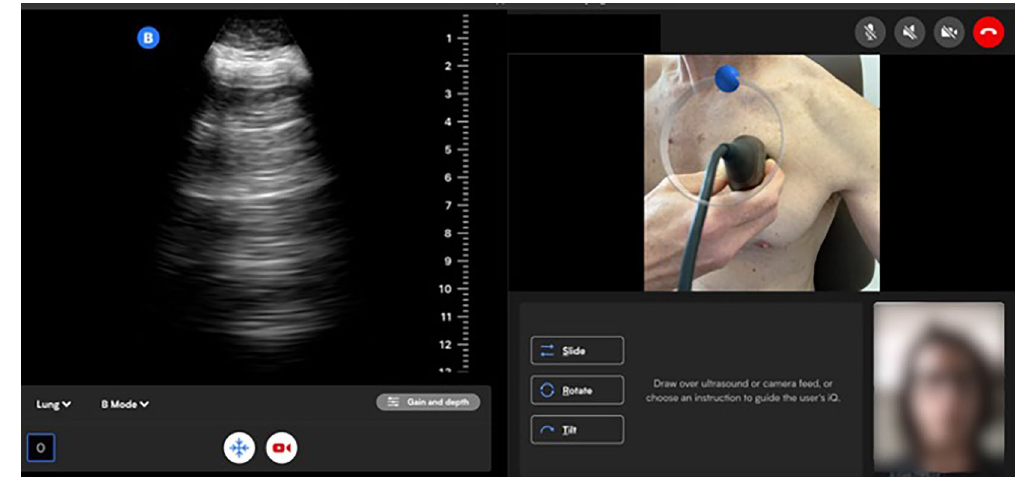
Fig. 1 Example of a patient‑performed remotely guided lung ultrasound session from the viewpoint of the guiding clinician